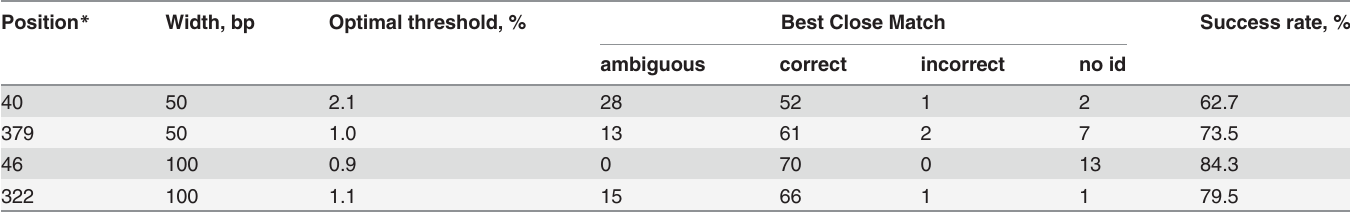
Table 3. Identi fi cation success for the best 100 bp and 50 bp mini-barcodes identi fi ed by sliding windows analysis in Spider. Position * Width,